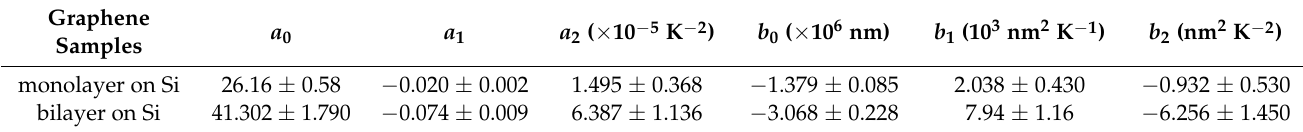
Figure 7. The parameters A 1 and B 1 as a function of temperature from 300 K to 500 K for the graphene on Si substrate. Table 4. The fitting parameters using Equation (2) for graphene on Si.